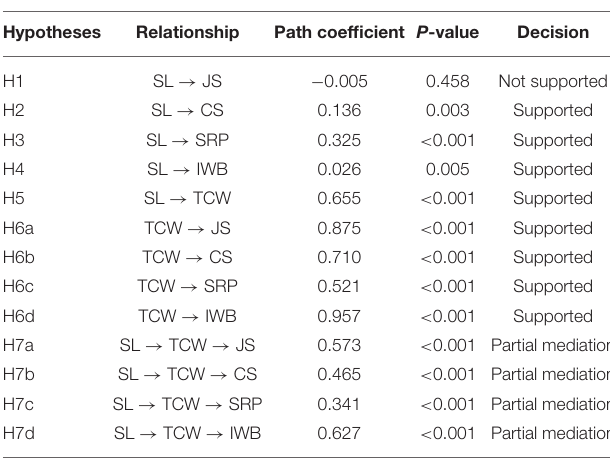
TABLE 3 | Stone-Geisser Q -squared coefficients.